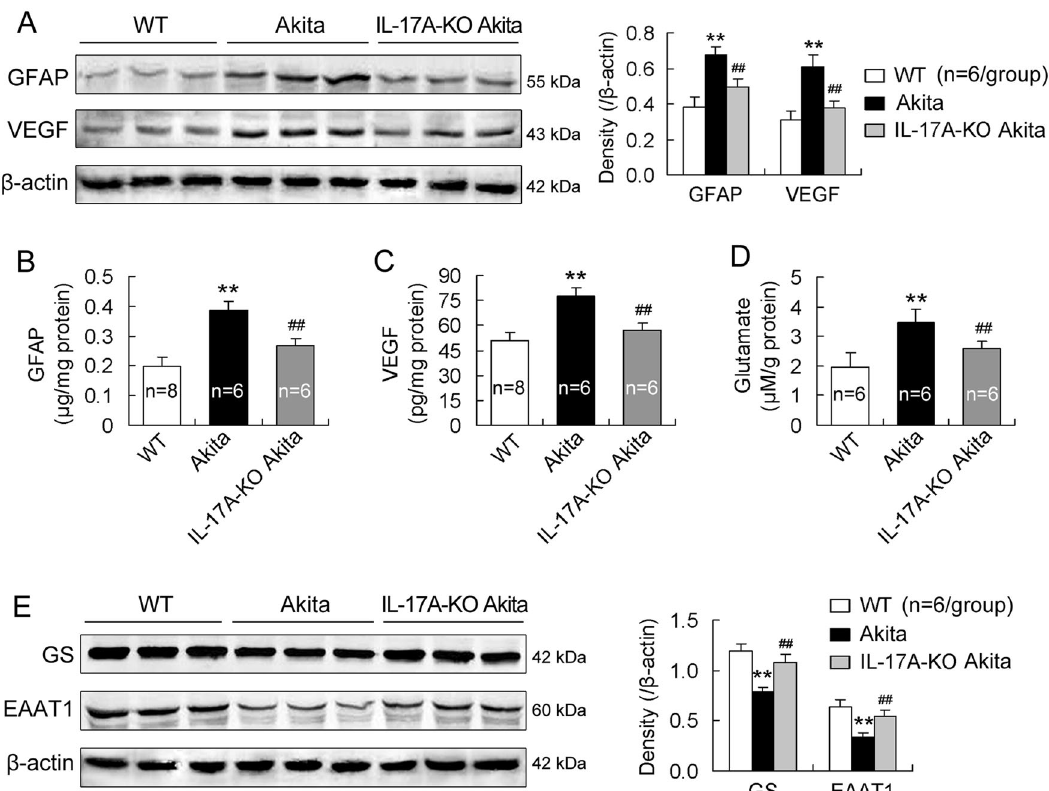
Fig. 2 IL-17A de fi ciency mitigates RMC activation and dysfunction in diabetic mice. The design of the mice was similar to that in Fig. 1. A Expression of GFAP and VEGF in the retina. The data in the statistical histogram were from six mice for each group. B , C GFAP and VEGF contents in the retina. The numbers in the statistical histogram indicate that eight or six mice were used in the groups. D Glutamate content in the retina detected by HPLC. The numbers in the statistical histogram represent that six mice were used in each group. E Retinal expression of GS and EAAT1. The data from six mice for each group were statistically analyzed. ** P < 0.01, versus WT mice; ## P < 0.01, versus Akita mice.